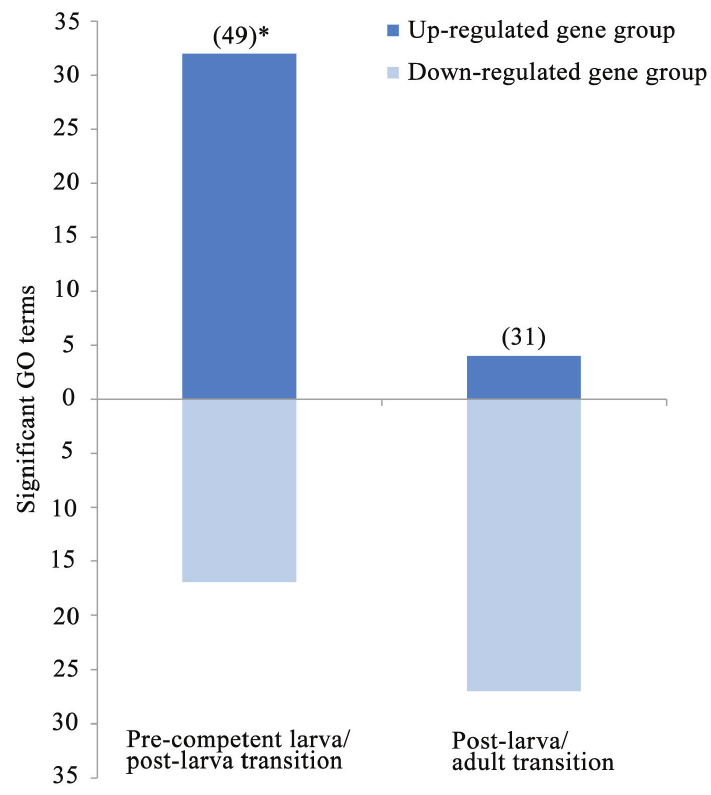
Figure 6. The frequencies of GO terms with significantly up- or down-regulated gene groups during the two life cycle transitions. These frequencies are for the subsets of 1025 and 716 annotated contigs in Figure 5A with a (cid:2)4-fold expression change during the pre-competent larva/post-larva and post-larva/adult transitions, respectively. ( ) = total numbers of significant GO terms (see Table 3 for a list of these designations); * = significant excess of up-regulated classes at p <